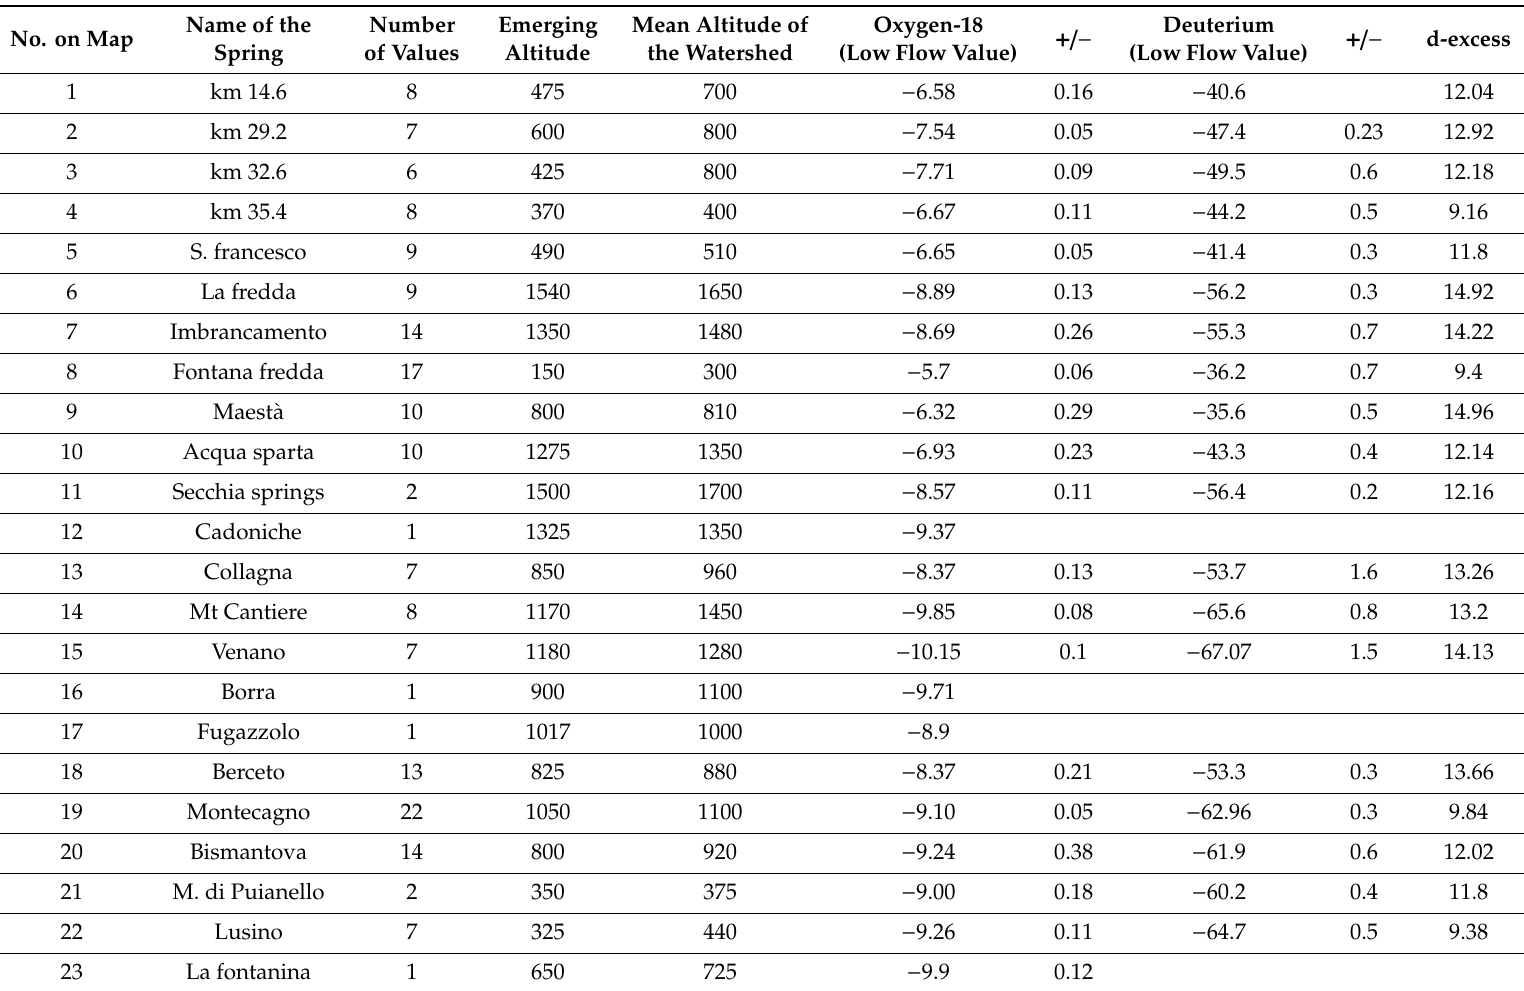
Table 1. Isotopic contents and main properties of the selected